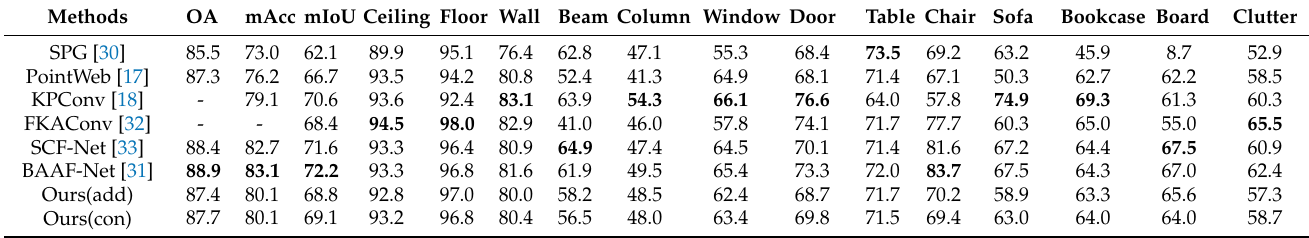
Table 2. Quantitative results on the S3DIS dataset (six-fold cross validation) (add: the two attention weight matrices added; con: the two attention weight matrices fused at the feature level).